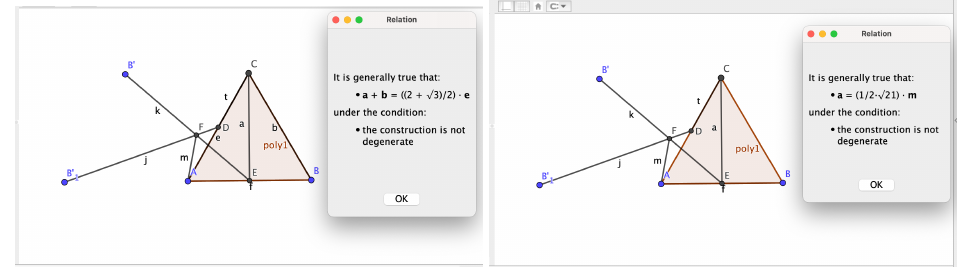
Figure 4. The Relation command finding quite complex